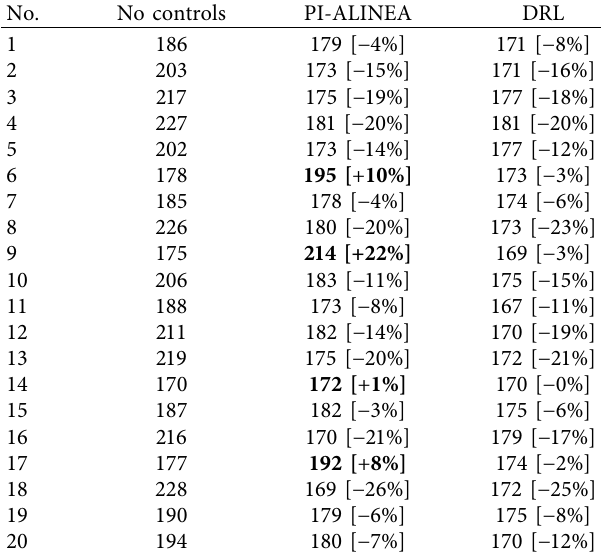
Table 2: Mean travel times in 20 simulation experiments (s).